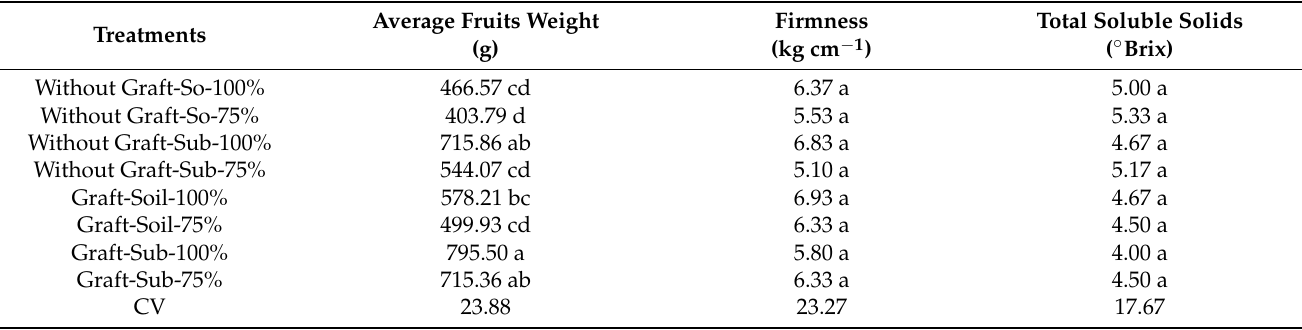
Table 2. Comparison of means between treatments for commercial variables of cucumber fruit.